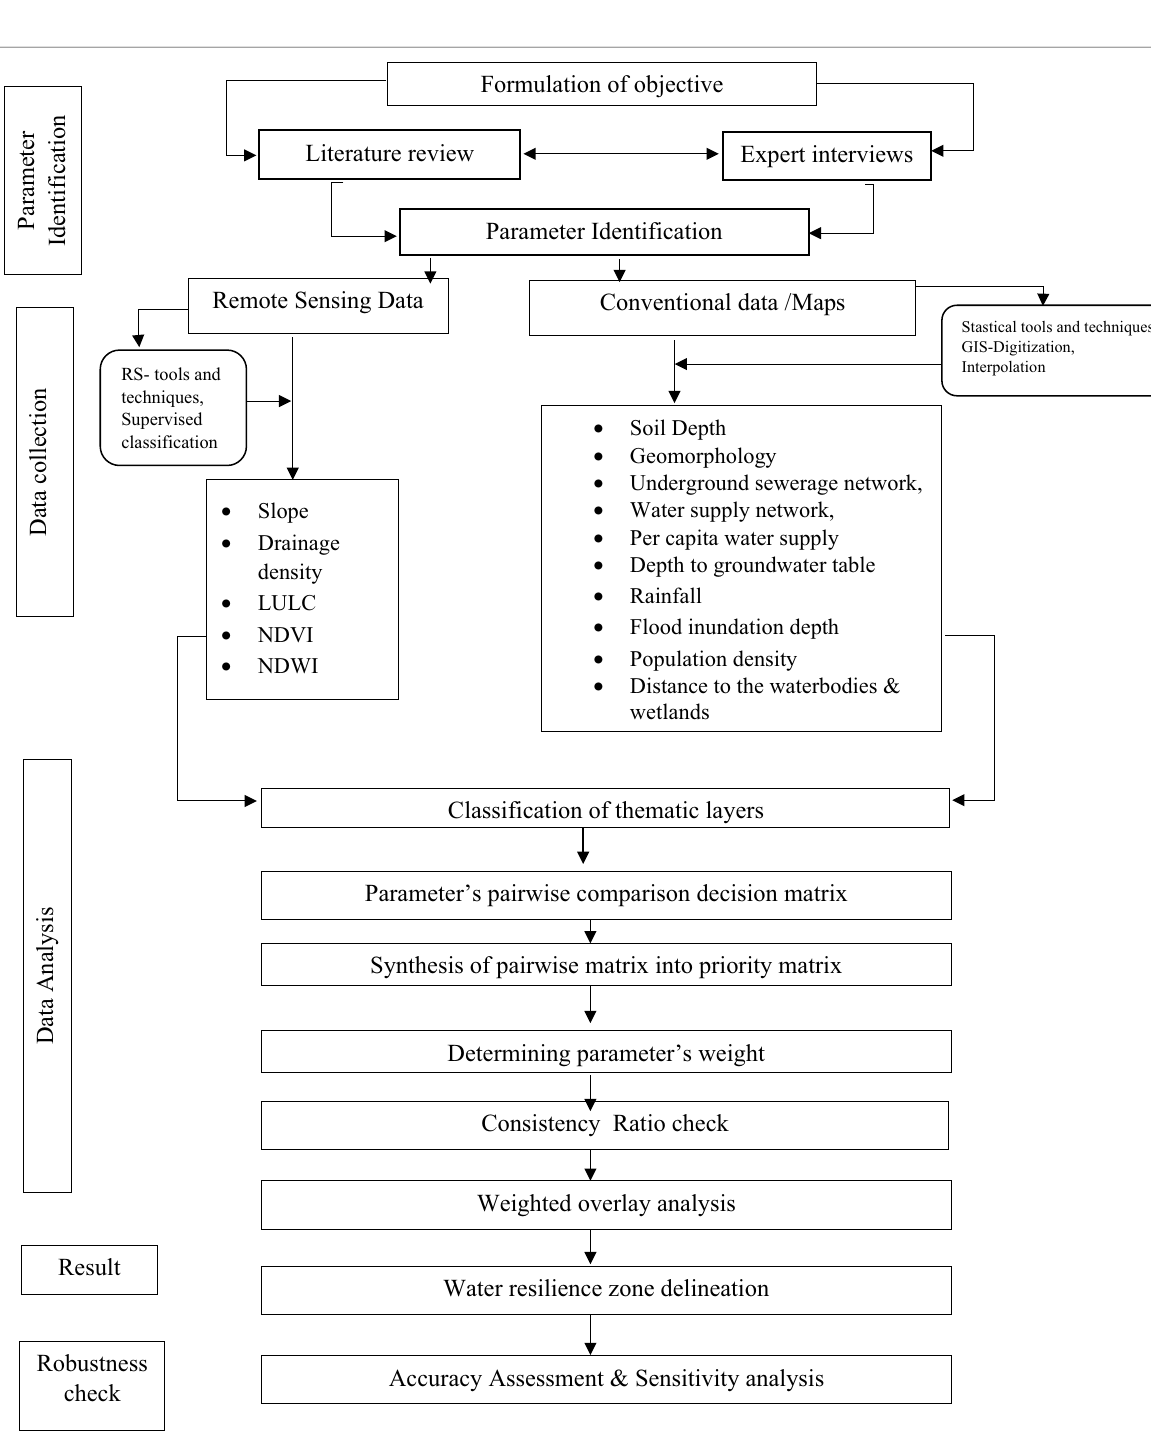
Fig. 2 Research method to evolve water resilience zone in the study